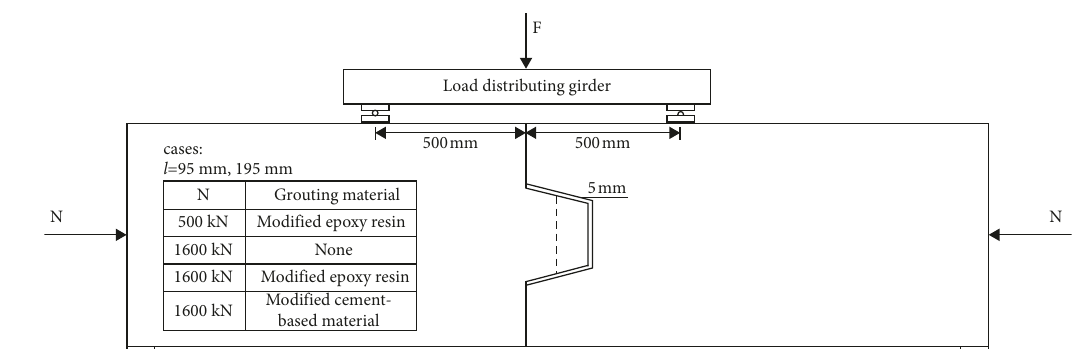
Figure 7: Loading configuration and cases.